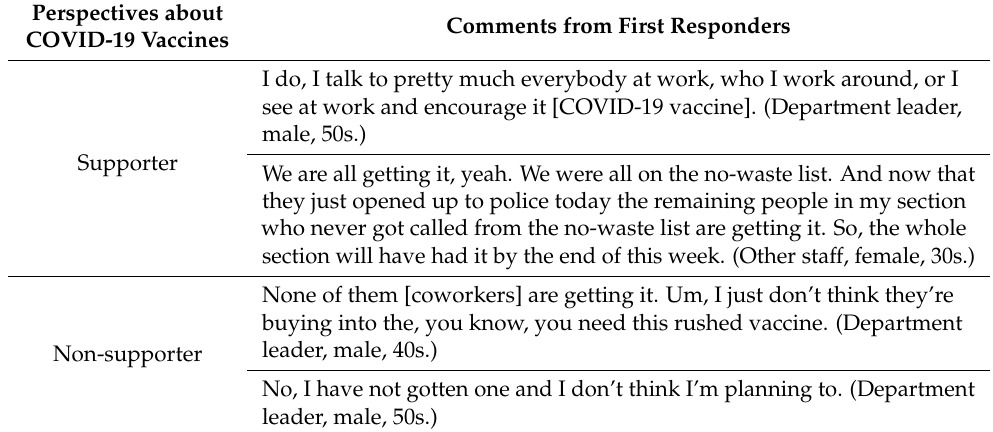
Table 3. Perceptions about COVID-19